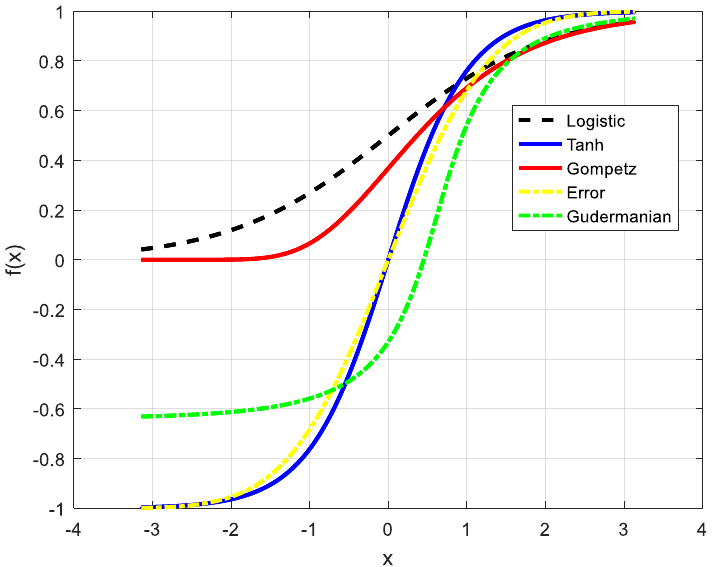
Figure 1. Five applied functions for updating outputs of continuous neurons.